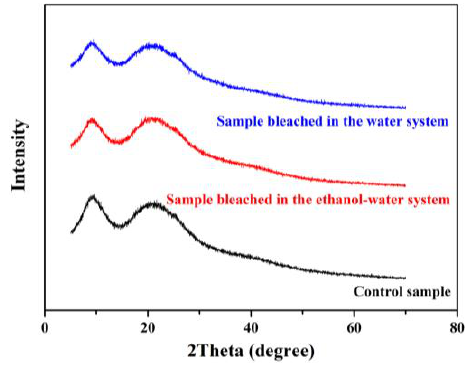
Figure 8. X-ray diffraction intensity curves of camel hair samples.